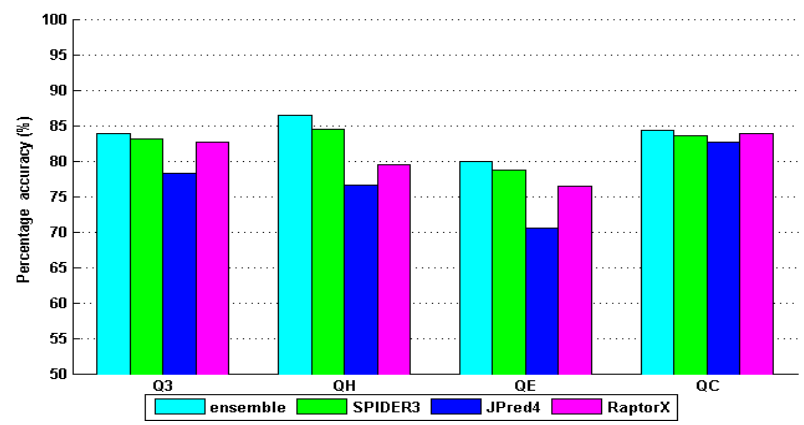
Figure 3. 𝑄 (cid:2871) Accuracy of ensemble model and the other three methods for data1199. Figure 3. Q 3 Accuracy of ensemble model and the other three methods for